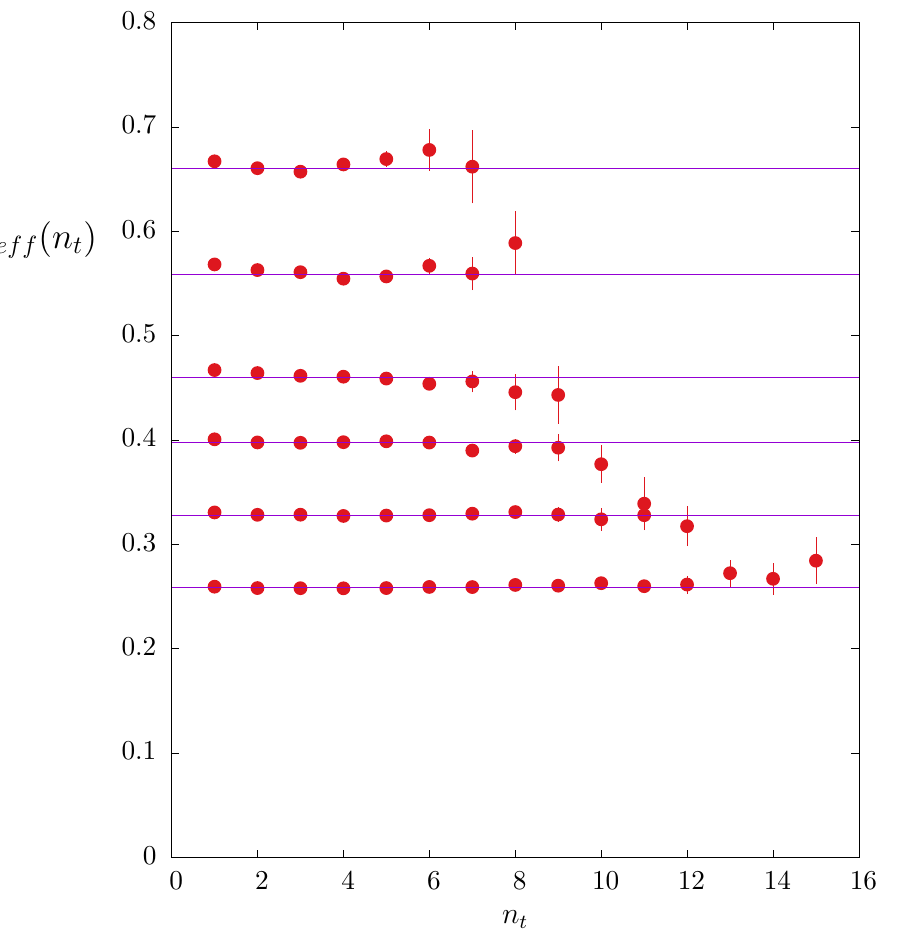
Figure 11 . E(cid:11)ective energy of a (cid:13)ux tube of length l in SO(6) at (cid:12) = 46, as a function of n t = t=a for l = 18 ; 22 ; 26 ; 30 ; 36 ; 42. Lines are our energy